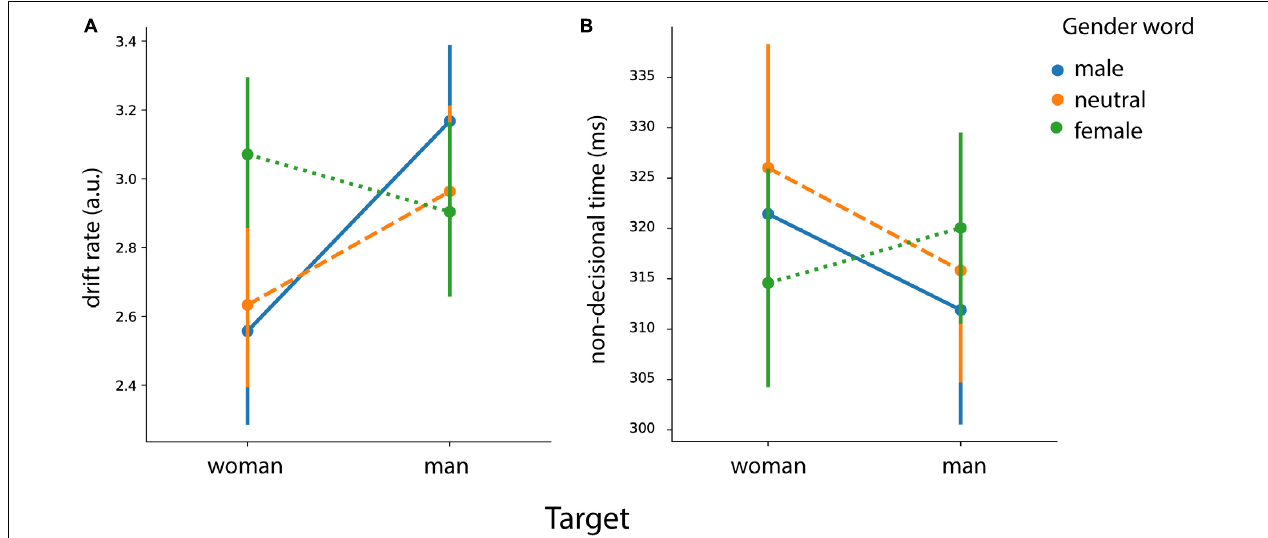
FIGURE 9 | Gender priming effects analysis. Posterior estimates of the hierarchical drift-diffusion model for (A) the drift rate ( v ) and (B) the non-decisional parameter ( T er ). Error bars represent 95% confidence interval